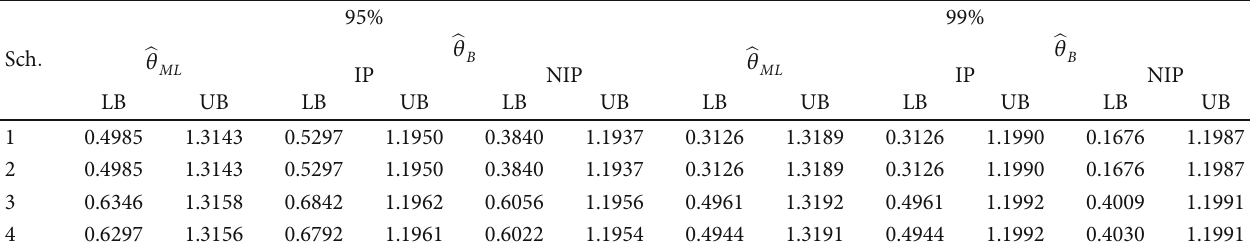
Table 10: The 95 % and 99 % con fi dence intervals estimates of θ based on the di ff erent Type-II uni fi ed PHCSs from real data. 95 % 99 % b θ Sch : ML